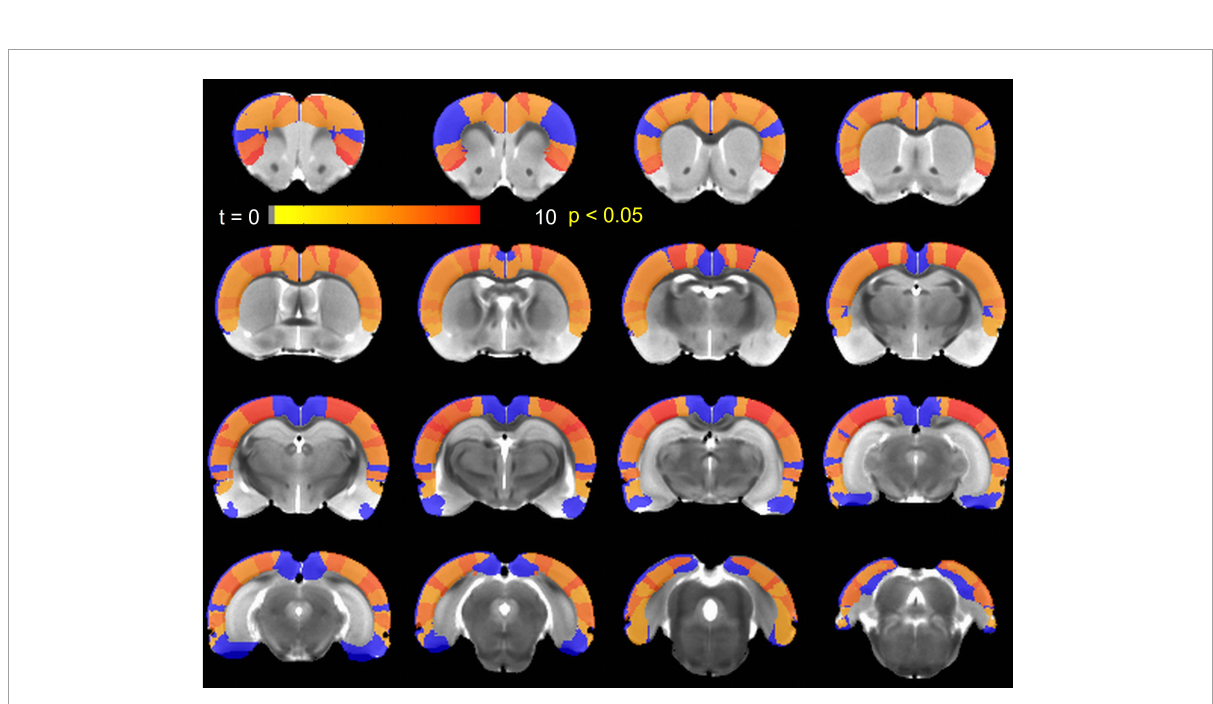
FIGURE2 Paxinos region of interest (ROIs) exhibiting significantly ( p < 0.05) enhanced interhemispheric homotopic functional connectivity (IHFC) relative to Baseline after TTA-P2 injection overlaid on a Paxinos atlas brain. ROIs shown in blue did not achieve